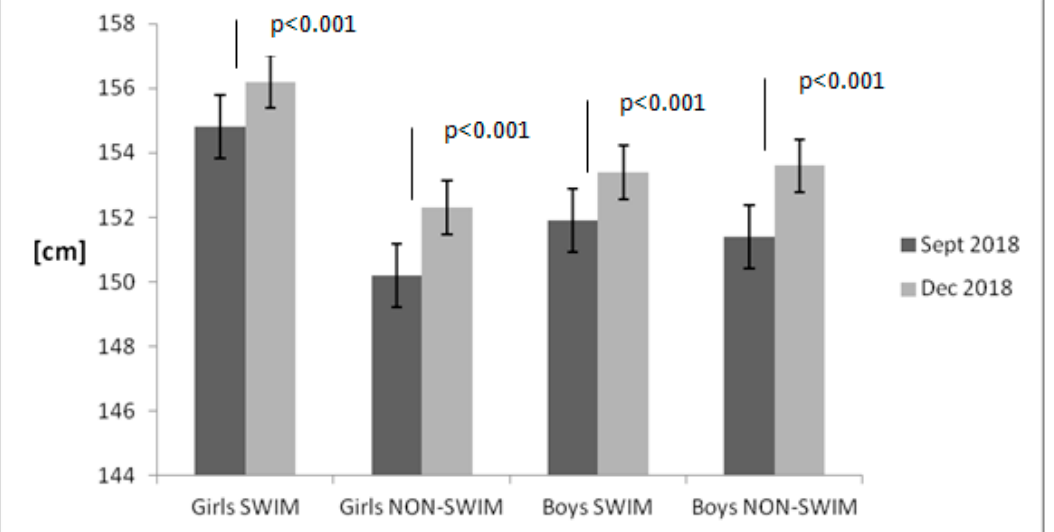
Figure 1. Body height changes in the examined groups of children. Data are presented as mean value and standard error. The non-swimmers group consisted of children participating in team sports (soccer, basketball), athletics, martial arts and dance.